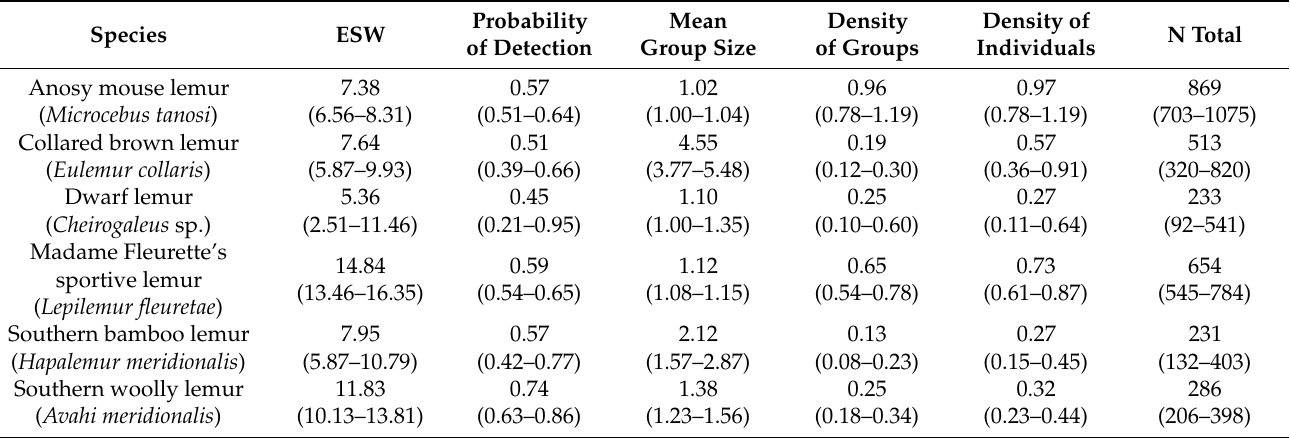
Table 4. Density estimates (groups and individuals per hectare) and total estimated number of individuals for six lemur species at the Ampasy valley (900 ha), north of the Tsitongambarika lowland rainforest, southeast Madagascar. Estimates are means and 95% CI obtained via Multiple Covariate Distance Sampling method. ESW: effective strip